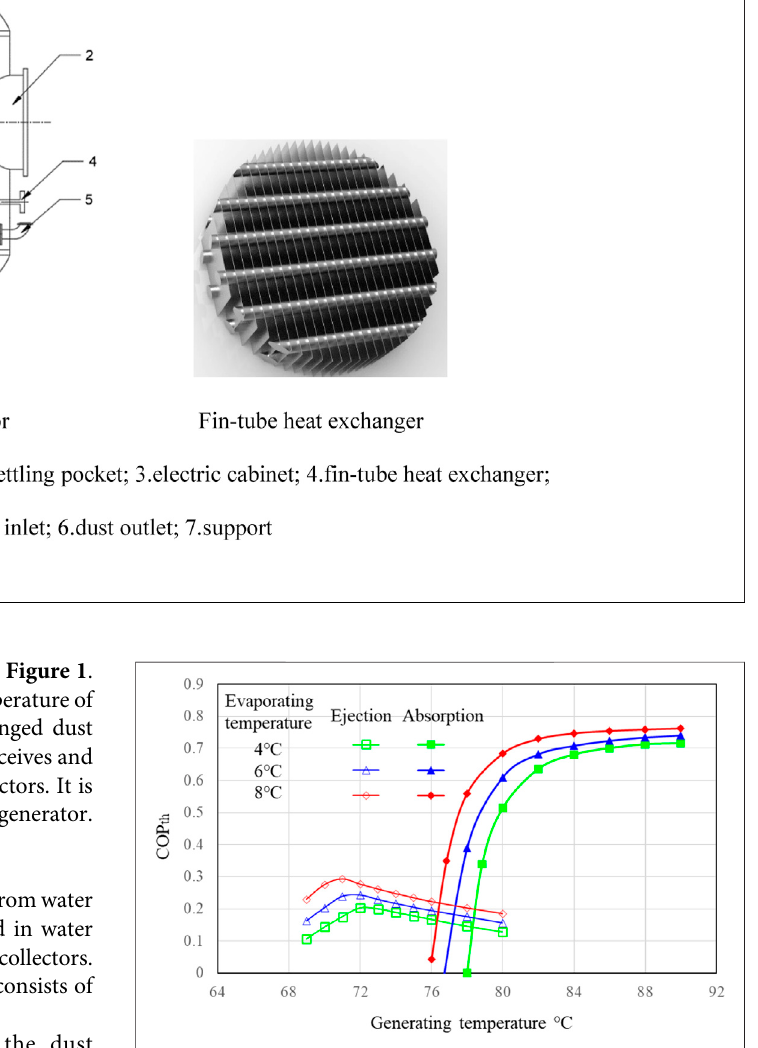
FIGURE 3 | Comparison of the performance of ejection and absorption refrigeration